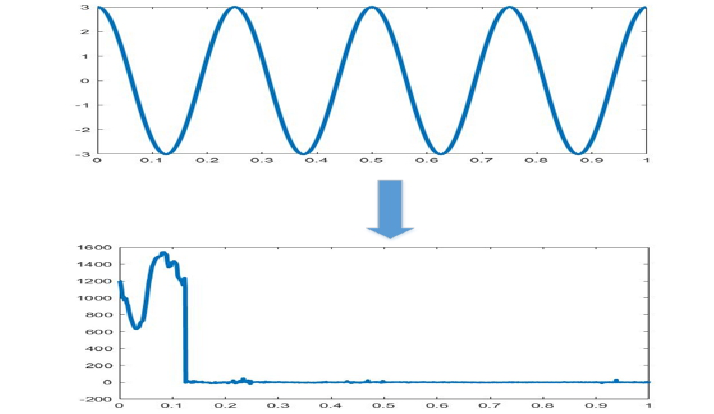
Figure 3. The effect of the wavelet transform compared with the Fourier transform. The upper denotes the effect of Fourier transform; the lower denotes the effect of the wavelet